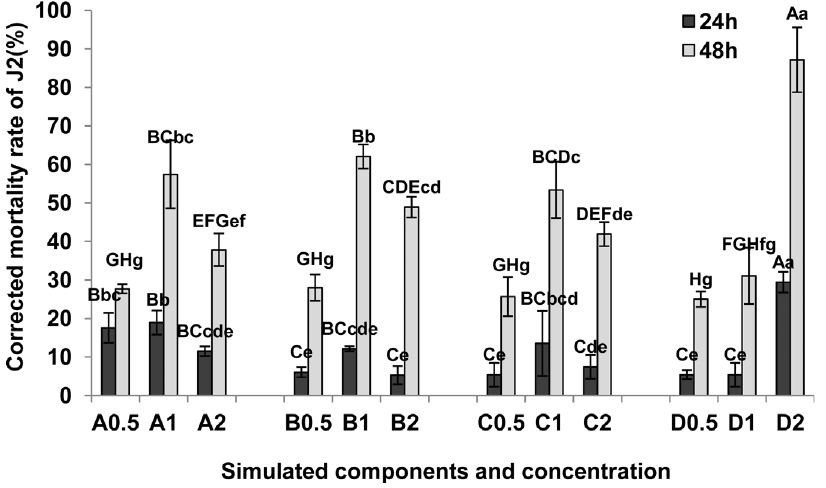
Fig 5. Effects of simulated components on corrected mortality of M . incognita J2. A, 2,6-Di-tert-butyl-p- cresol; B, L-ascorbyl-2,6-dipalmitate; C, dibutyl phthalate; D, dimethyl phthalate; 0.5,0.5 mmol (cid:1) L -1 ; 1,1 mmol (cid:1) L -1 ; 2,2 mmol (cid:1) L -1 . The mortality of J2 in each treatment (1.0% ethanol as control) was assessed by the eyelash needle stimulus method at 24 h and 48 h after starting the assay. Corrected mortality rate (%) = (mortality rate of J2 in treatment — mortality rate of J2 in control) / (1 — mortality rate of J2 in control) ×100. Each bar represents the mean, and error bars indicate standard error of the mean from three replicates. Capital and lower case letters indicate significant group differences at the levels of 0.01 and 0.05,